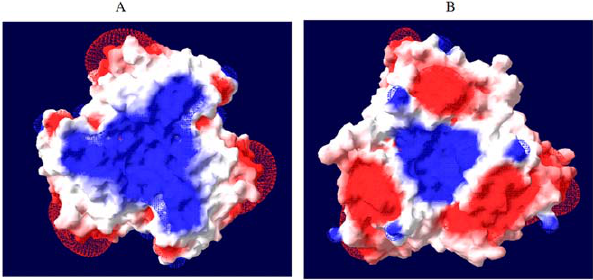
Figure 2. Theoretical model of the VP10 of LNV based on the atomic structure of the homologous VP9 of BAV. A: the BAV VP9 atomic structure, B: theoretical model of the VP10 of LNV. The model was constructed using the programme MODELLER. The mutation (A82 R N82) found in the VP10 of the virus isolated on cell culture from the mouse blood collected at 3 days post-injection and the virus identified in the spleen 2 weeks post-injection of LNV-9712, mapped to the basic (blue colour) depression on the surface of the VP10